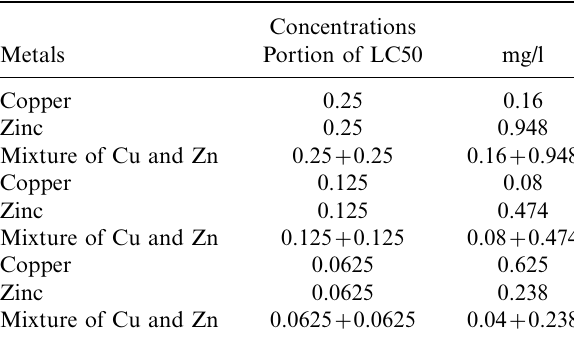
Table 1. Concentrations of Cu and Zn in mixture